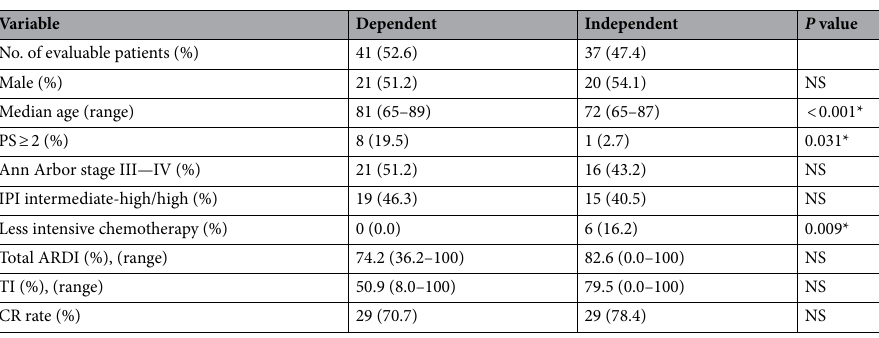
Table 3. Clinical characteristics of 78 patients classified as dependent or independent according to a CGA. ARDI average relative dose intensity of cyclophosphamide, doxorubicin, and vincristine, Total ARDI average actual ARDI during the total treatment period, CGA comprehensive geriatric assessment, CR complete response, IPI International Prognostic Index, NS not significant, PS performance status, P -value, Wilcoxon rank sum test for continuous variables and Pearson’s chi-squared test or Fisher’s exact test for nominal scale variables. TI Treatment intensity is the ratio of total actual dose during the total treatment period to the standard total dose in standard courses. *Comparison between dependent and independent.